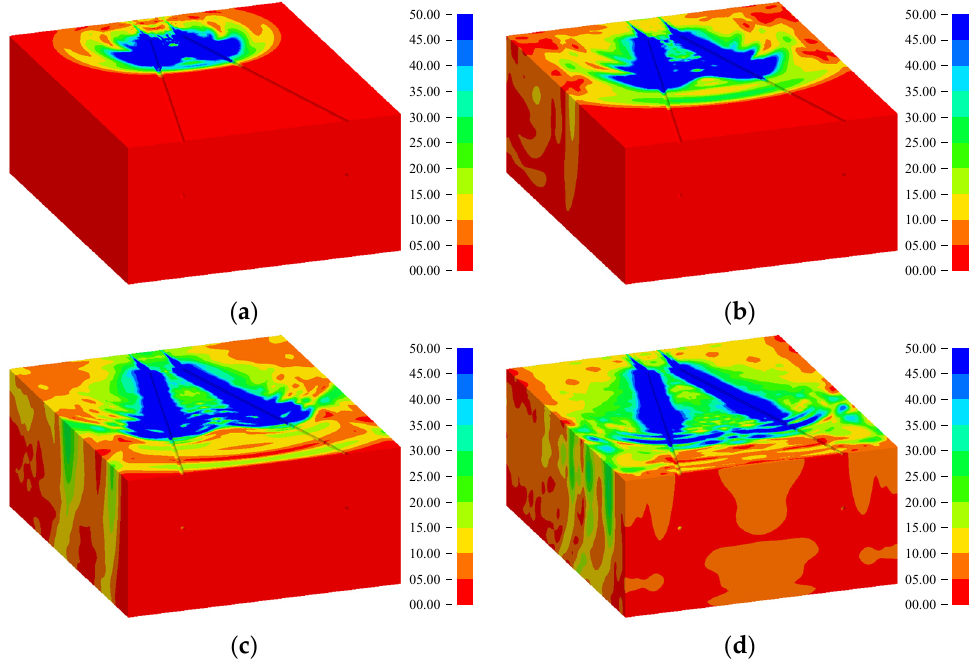
Figure 7. Stress wave propagation under the condition of Φ 50 mm holes matching Φ 42 mm cartridges. ( a ) Time = 160 µs. ( b )Time = 320 µs. ( c ) Time = 470 µs. ( d ) Time = 600 µs.